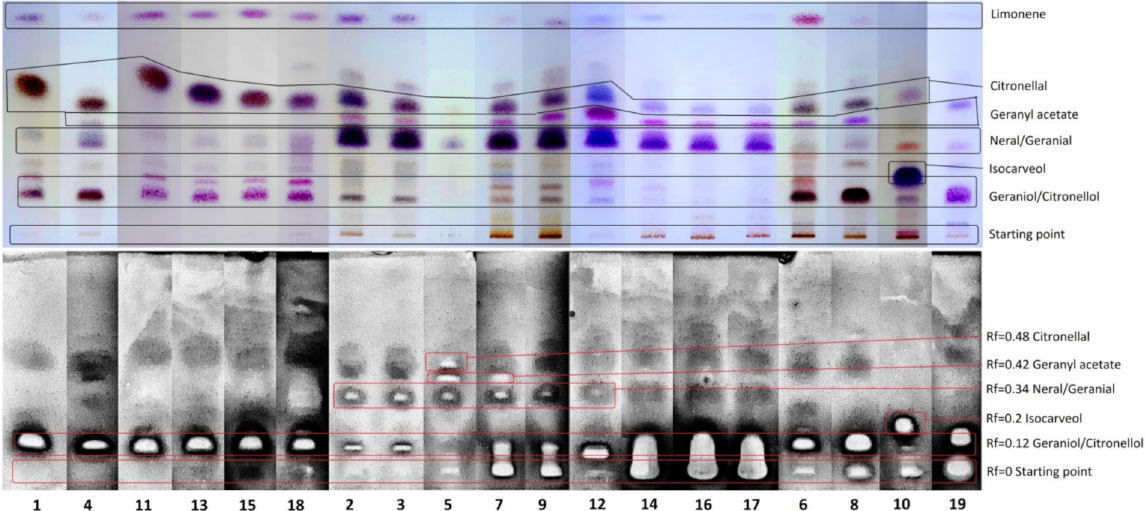
Figure 2. TLC separation of essential oils from Cymbopogon species ( chromatogram above ) and detection of anti-MRSA activity by direct bioautography ( chromatogram below ). Adsorbent, silica gel 60 F254. Solvent, hexane–ethyl acetate, 9 + 1 ( v / v ). Detection of upper chromatogram, alcoholic vanillin–sulphuric acid reagent. For EO numbering, see Table